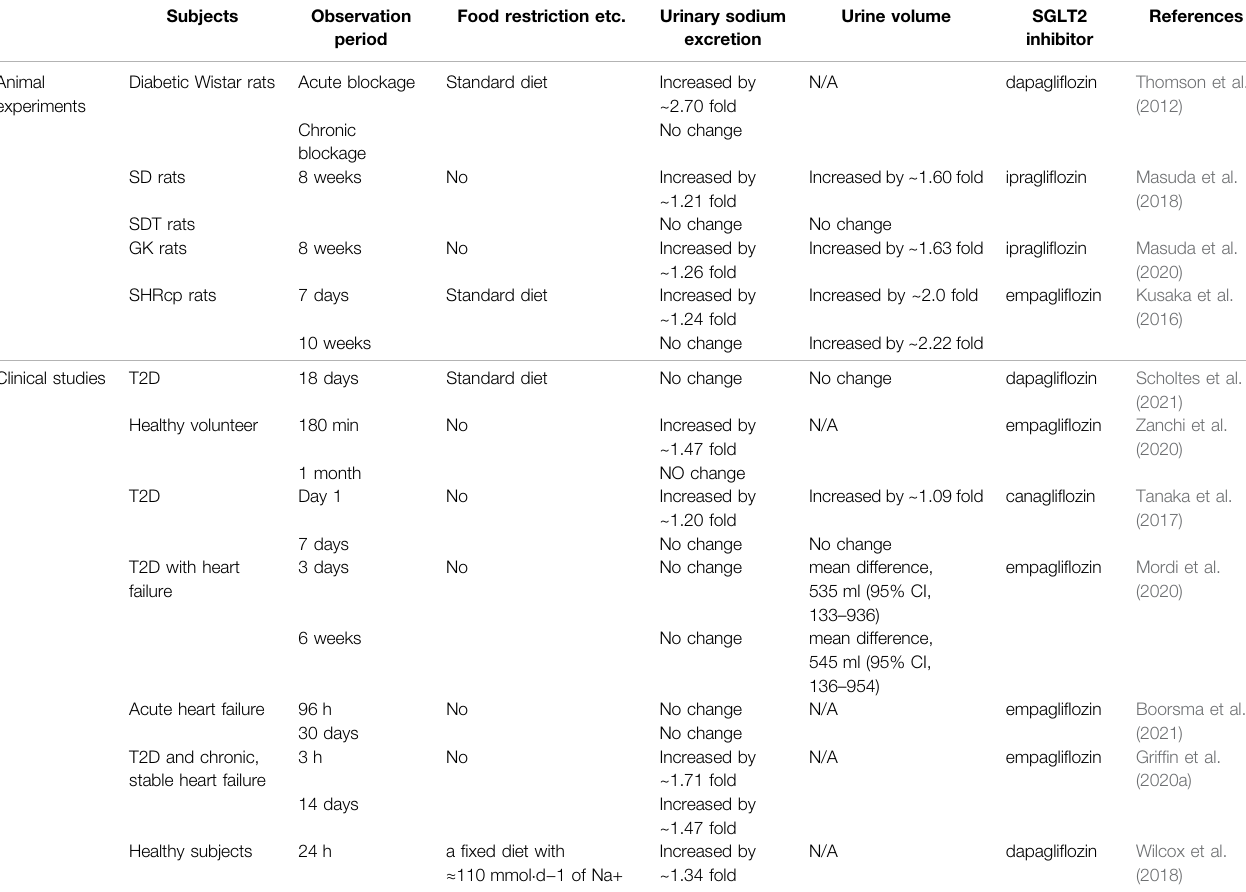
TABLE 1 | SGLT2 inhibitors-induced changes in urinary sodium excretion and urinary